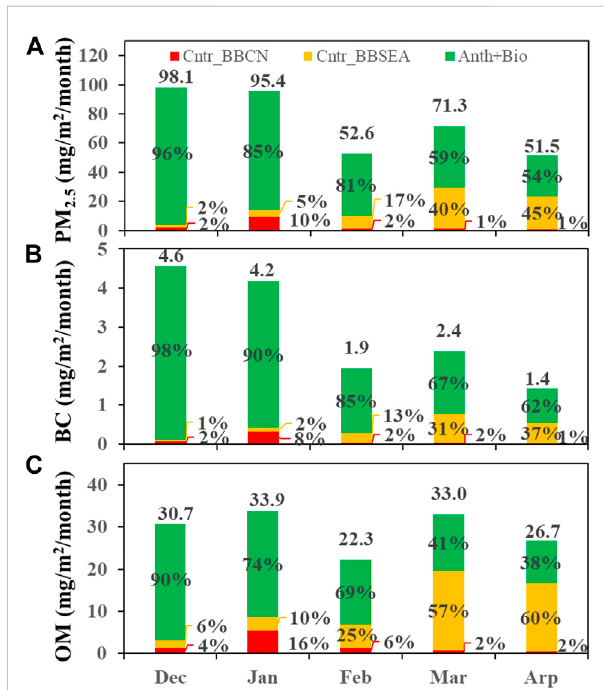
FIGURE 6 Modeled monthly and NSCS regional mean aerosol depositions of (A) PM 2.5 , (B) BC, and (C) OM. Numbers on the top of each bar are the mean depositions. Contributions from anthropogenic and biogenic sources (NOBB, green), biomass burning emissions from mainland Southeast Asia (Cntr_BB SEA , red), and biomass burning emissions from China (Cntr_BB CN , orange) are shown in percentages. The NSCS region is indicated in Figure